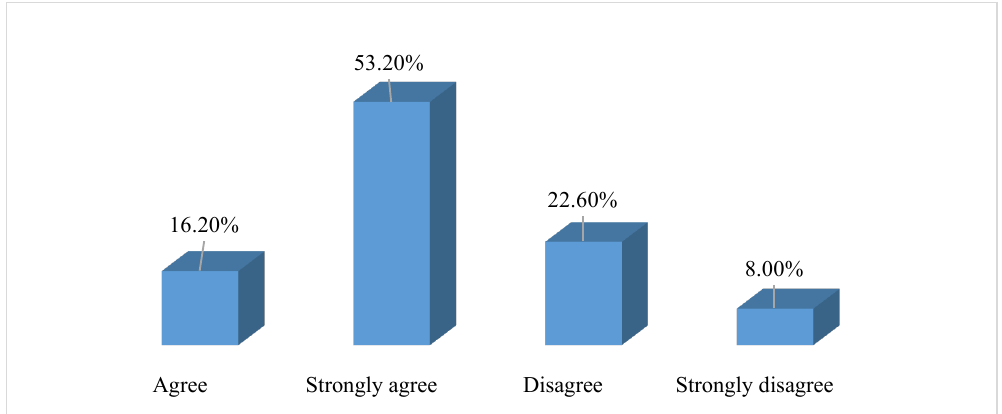
Fig. 1. Stress negatively affects performance at work. Source: The authors’